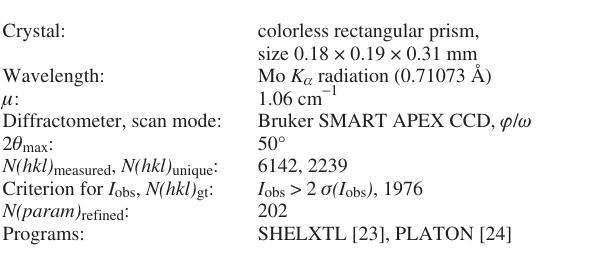
Table 1. Data collection and